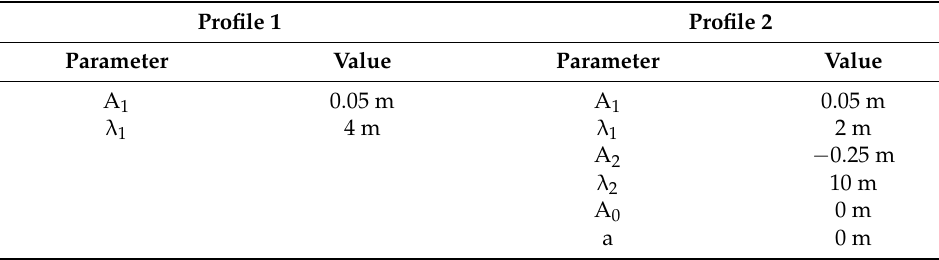
Table 2. Ground function